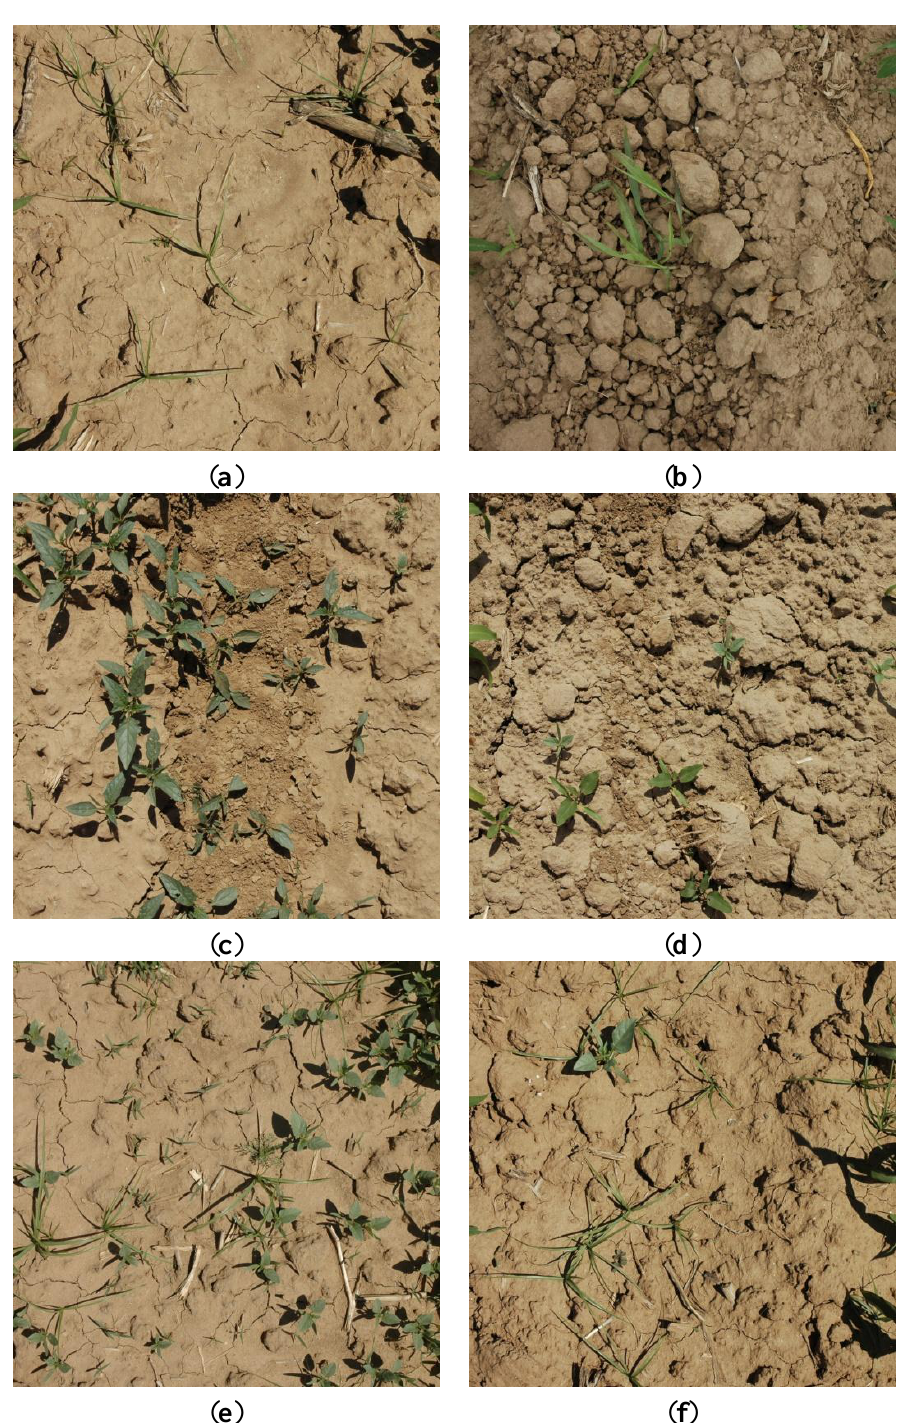
Figure 2. Images ( a , b ) show monocots (long and slender leaf), whereas images ( c , d ) present dicots (broadleaf and short). Images ( e , f ) display a mixture of both weed